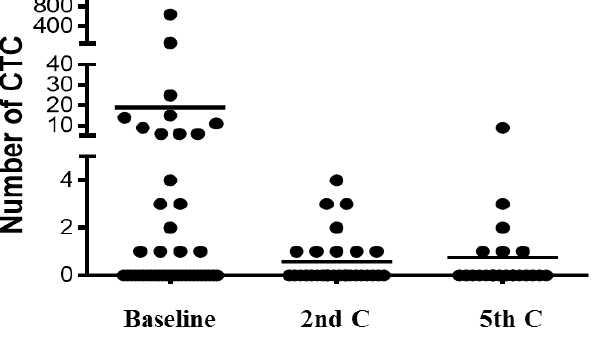
Figure 3. CTC levels at baseline, 2nd and 5th cycle of